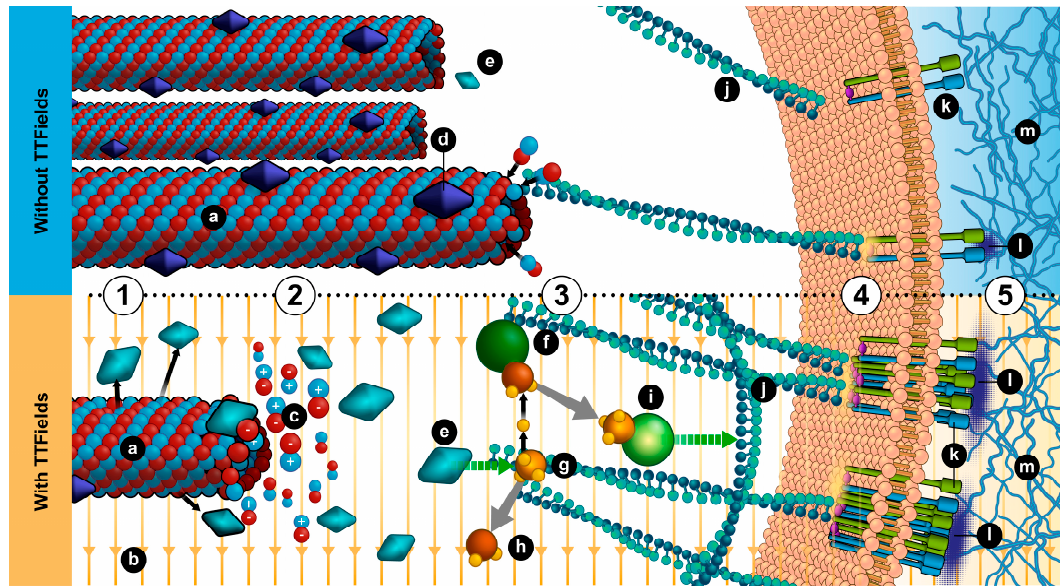
Figure 6. A model illustrating the mechanism by which TTFields modulates cancer cell motility . (1) Microtubules are required to specify the direction of cell movement. GEF-H1 catalytic activity is downregulated through microtubule binding. (2) TTFields exert directional forces on polar tubulins leading to their alignment in the direction of the field. This in turn, leads to the reorganization of the microtubule network resulting in changes in the number of microtubules, interference with the directionality of cellular migration, and initiation of the GEF-H1/RhoA/ROCK signaling pathway (3) to control actin dynamics (4) and formation of focal adhesions (5), which disrupt cell polarity and migration directionality. a , microtubule; b , TTFields; c , tubulin aligned with field; d , GEF-H1; e , active GEF-H1; f , Rho-A GDP; g , GTP; h , GDP; i , Rho-A GTP; j , actin fiber; k , integrin; l , focal adhesion; m , extracellular matrix.